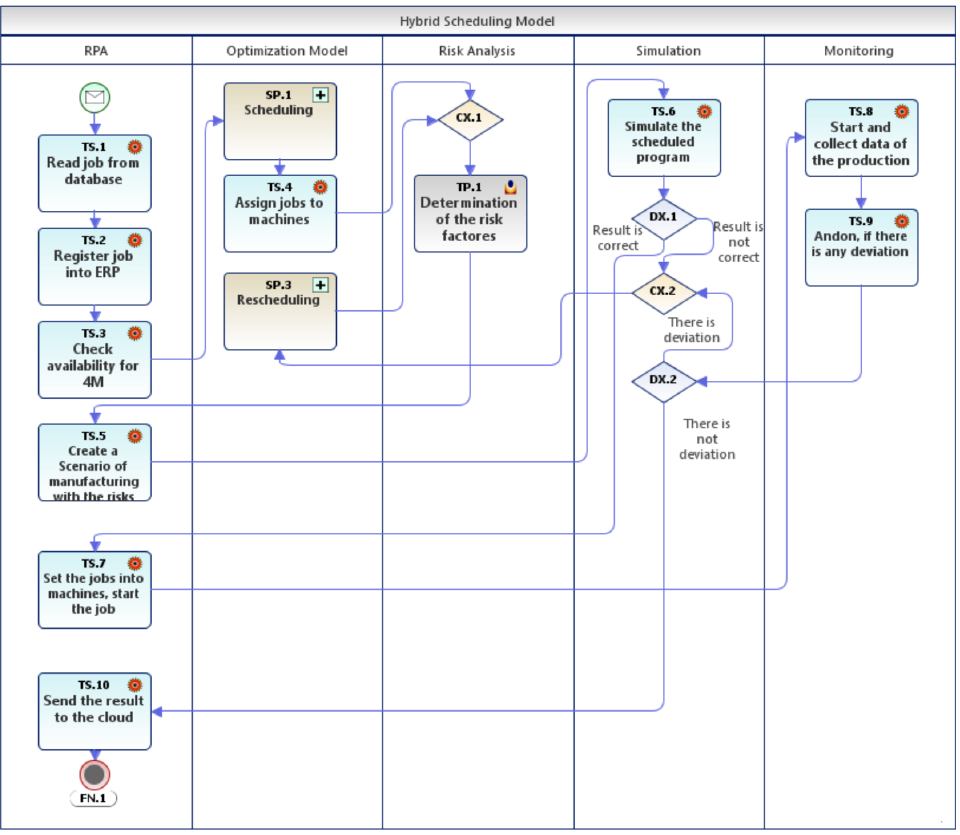
Figure 5. Hybrid scheduling model by robotic process automation